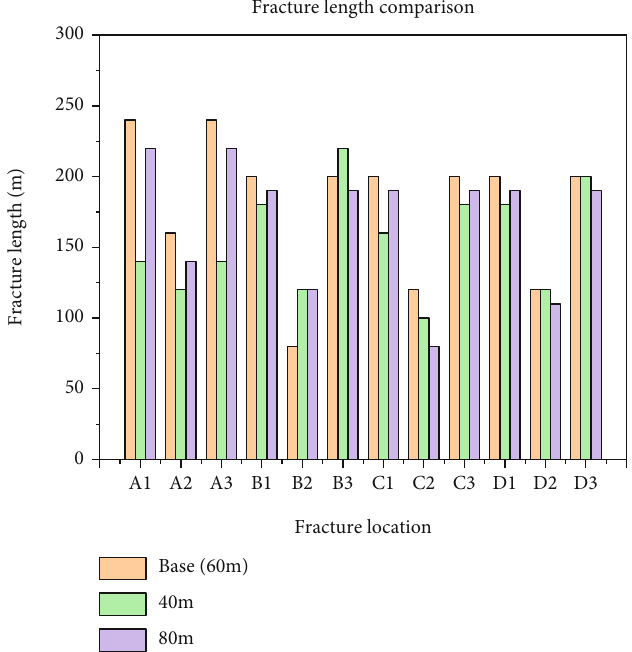
Figure 5: Comparison of fracture length for scenarios with di ff erent stage